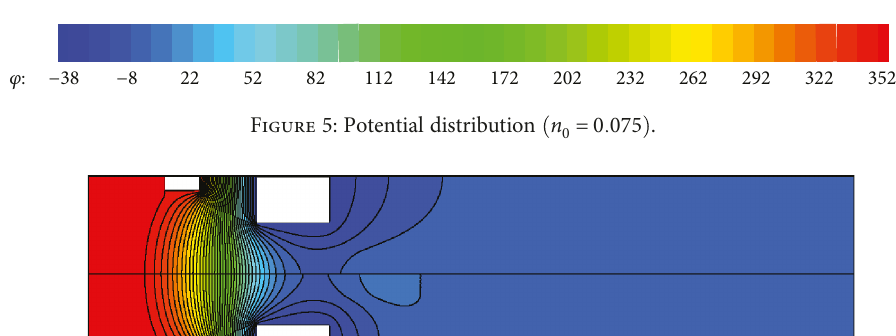
Figure 6: Potential distribution n